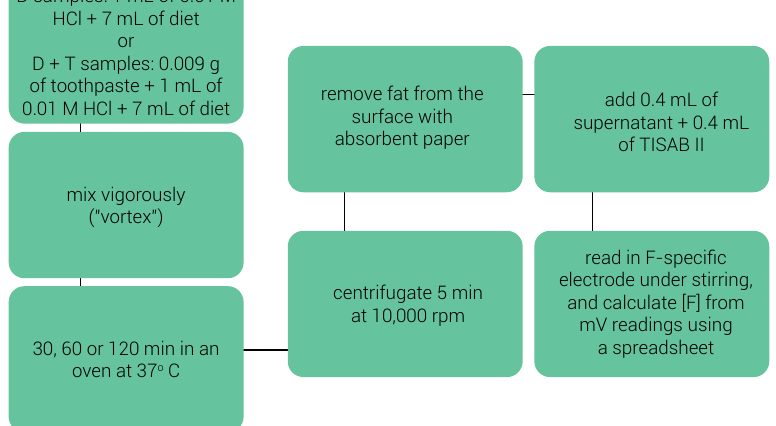
Figure 1. F determination using the “gastric juice”